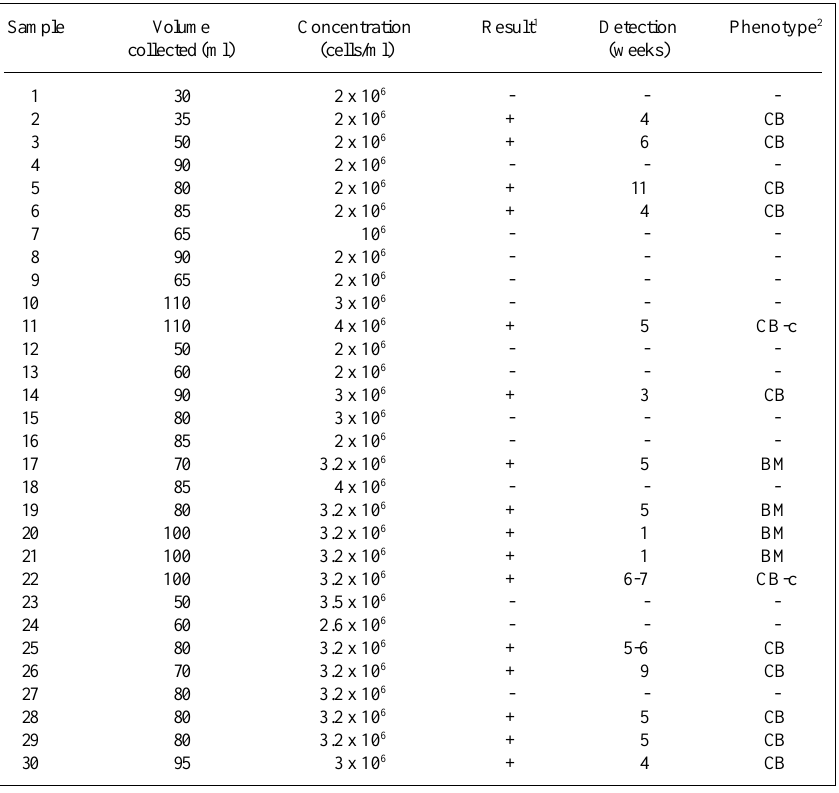
Table I - Formation, detection time and phenotype of an adherent layer in human umbilical cord cell cultures initiated with different cell concentrations.